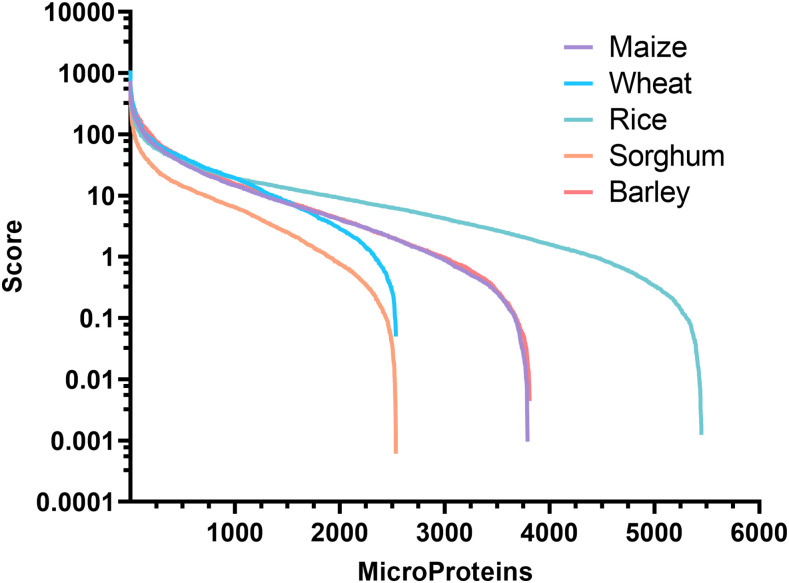
Score distribution of identified candidate microProteins as assigned by miPFinder.